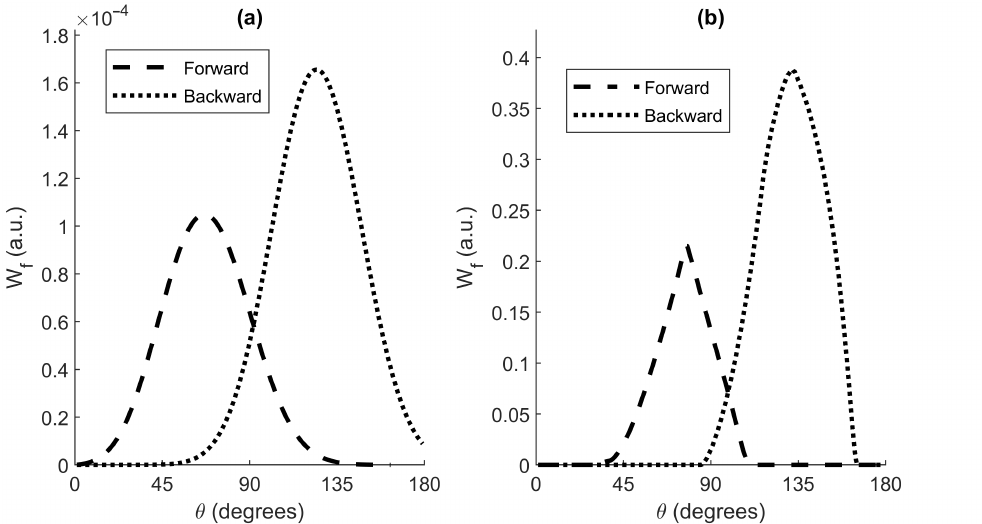
Figure 5. Angular weighting functions of the dust sensor for both configurations as a function of the scattering angle ( θ ). ( a ) W f using Equation (8). ( b ) W f , ideal using the Equation